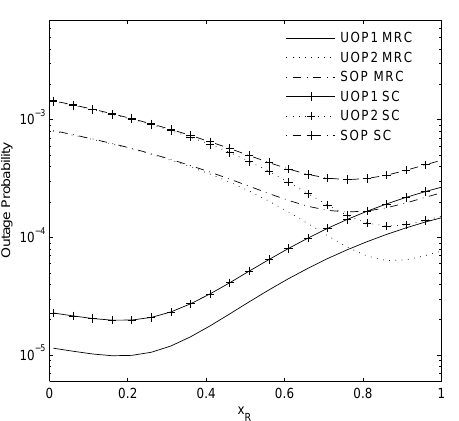
Figure 5. Outage Probability versus the position of relay with γ = 30 dB, R = 1 and η = 3 .